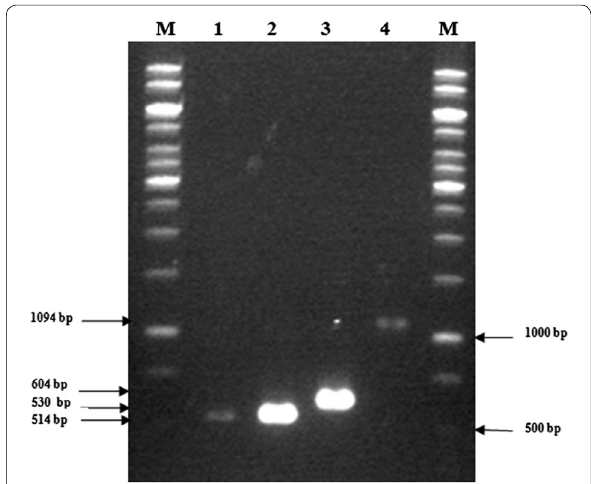
Fig. 2 PCR confirmation of the transformed LBA4404 colonies containing; pGDD, pGFF, pGFFDD and pGCGi constructs. The line numbers 1, 2, 3 and 4 are amplified PCR product with specific primers PSh4-F/R related to the transformed Agrobacterium containing pGDD (514 bp), pGFF (530), pGFFDD (604 bp) and pGCGi (1094 bp), respectively, M is 1 kb DNA size